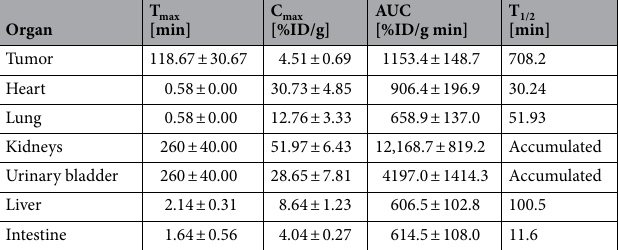
Table 1. Pharmacokinetic parameters of [ 68 Ga]PSMA-11. Values are the mean ± SEM ( n = 3).